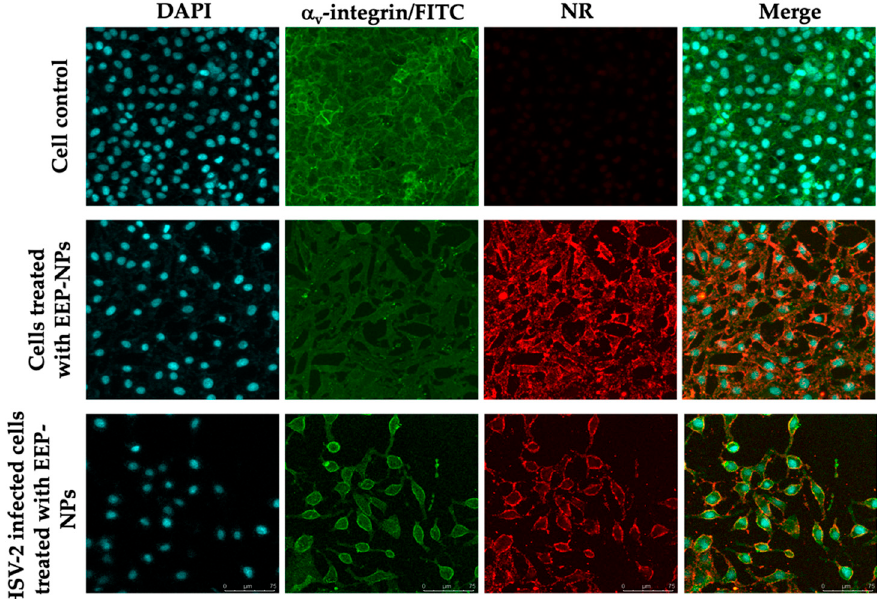
Figure 6. Blocking of virus entry and release by the EEP-NPs. The EEP-NPs were traced with NR (red). The nucleus and the membrane were indicated using DAPI staining (blue) and a mouse anti- α v -integrin mAb followed by an FITC-conjugated anti-mouse pAb (green), respectively.